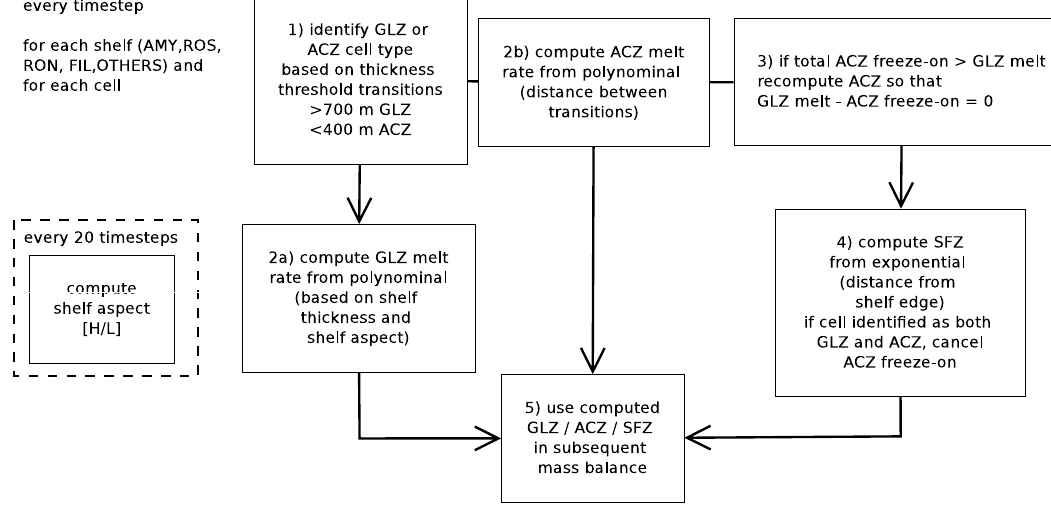
Fig. 2. SSM (sub-ice-shelf melt) implementation flowchart, with details for each distinct process zone: GLZ (grounding line zone), ACZ (accretion), and SFZ (shelf front).